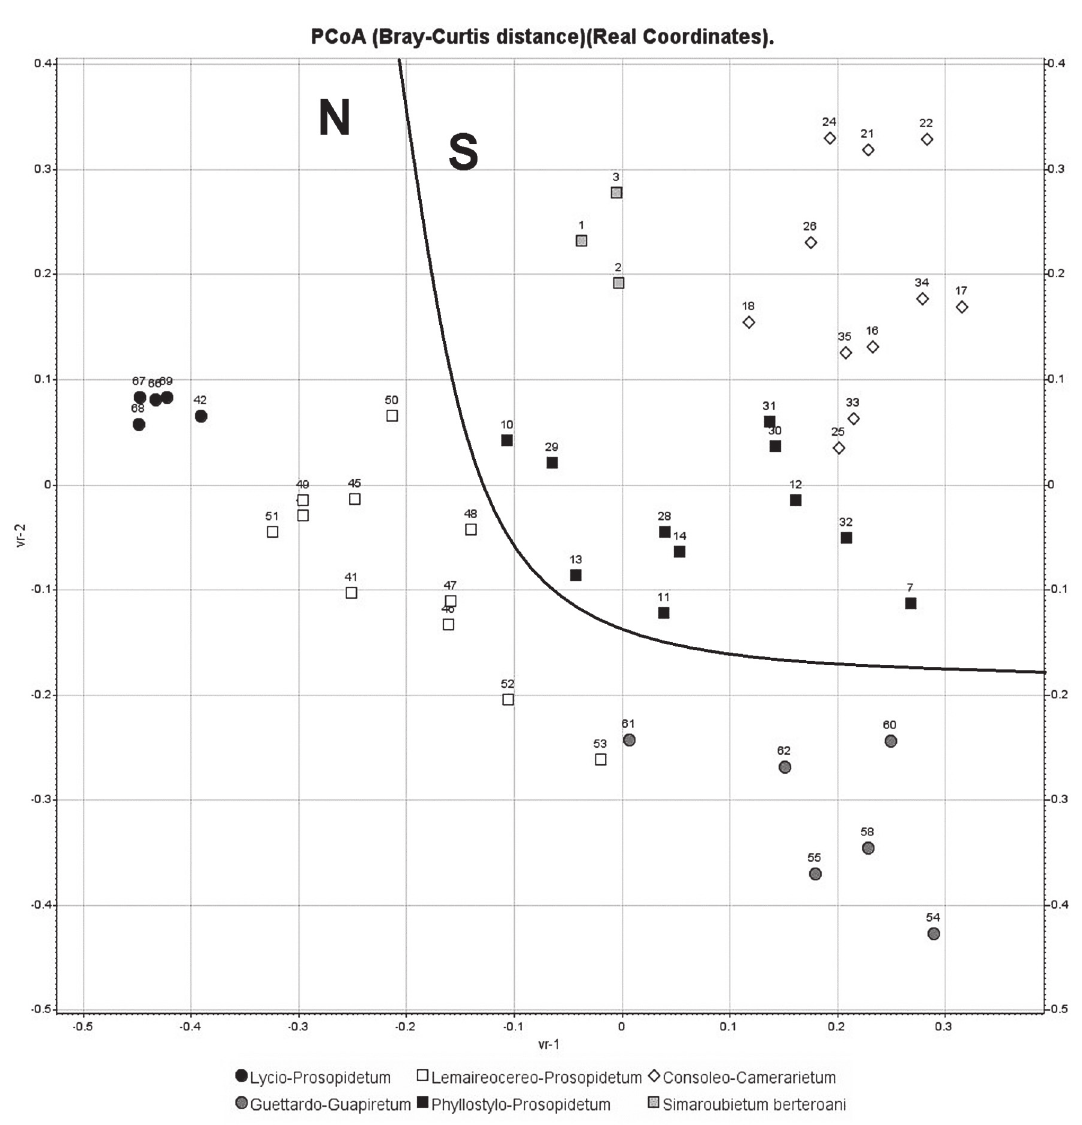
Figure 3 - Principal Coordinate Analysis (PCoA) for groups with tree-like and shrub-like vegetation. The dividing line separates the associations found in the south (S) and those found in the north (N) of the Dominican